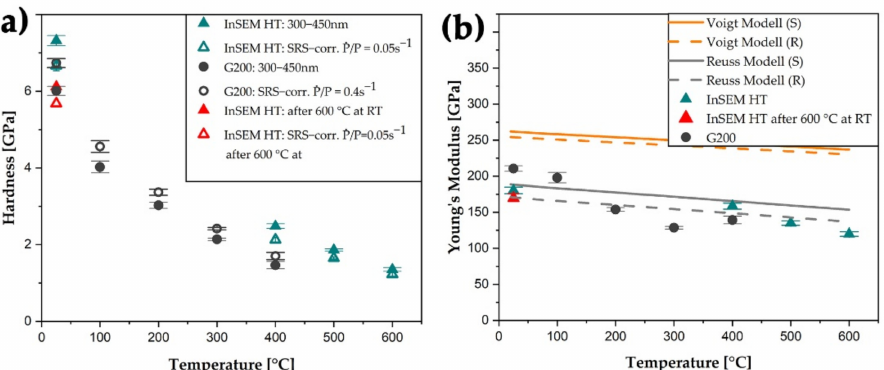
Figure 4. In ( a ) the evolution of the hardness as a function of the temperature of the nc W/Cu composite material is displayed. The data include a standard deviation calculated from at least five indents and was corrected according to the given constant indentation strain rate. The Young (cid:48) s modulus as a function of the temperature is shown in ( b ). Guidelines based on literature data were included to guide the reader (cid:48) s eyes [31,32]. Therefore, the anisotropic Young (cid:48) s modulus of Cu was calculated after Shtrikman (S) and Reuss (R) bounds. The open symbols constitute strain- rate-corrected data points, and the red triangles display data points recorded subsequently to the high-temperature experiments at RT. Here, only a minor deviation of 16 and 5% from the hardness and Young (cid:48) s modulus was determined, respectively. For a colored version of this article, the reader is referred to the online